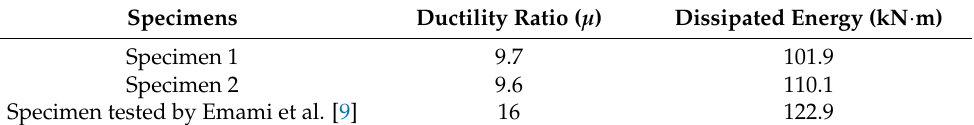
Figure 15. Inelastic behavior of the panel, beam and column.